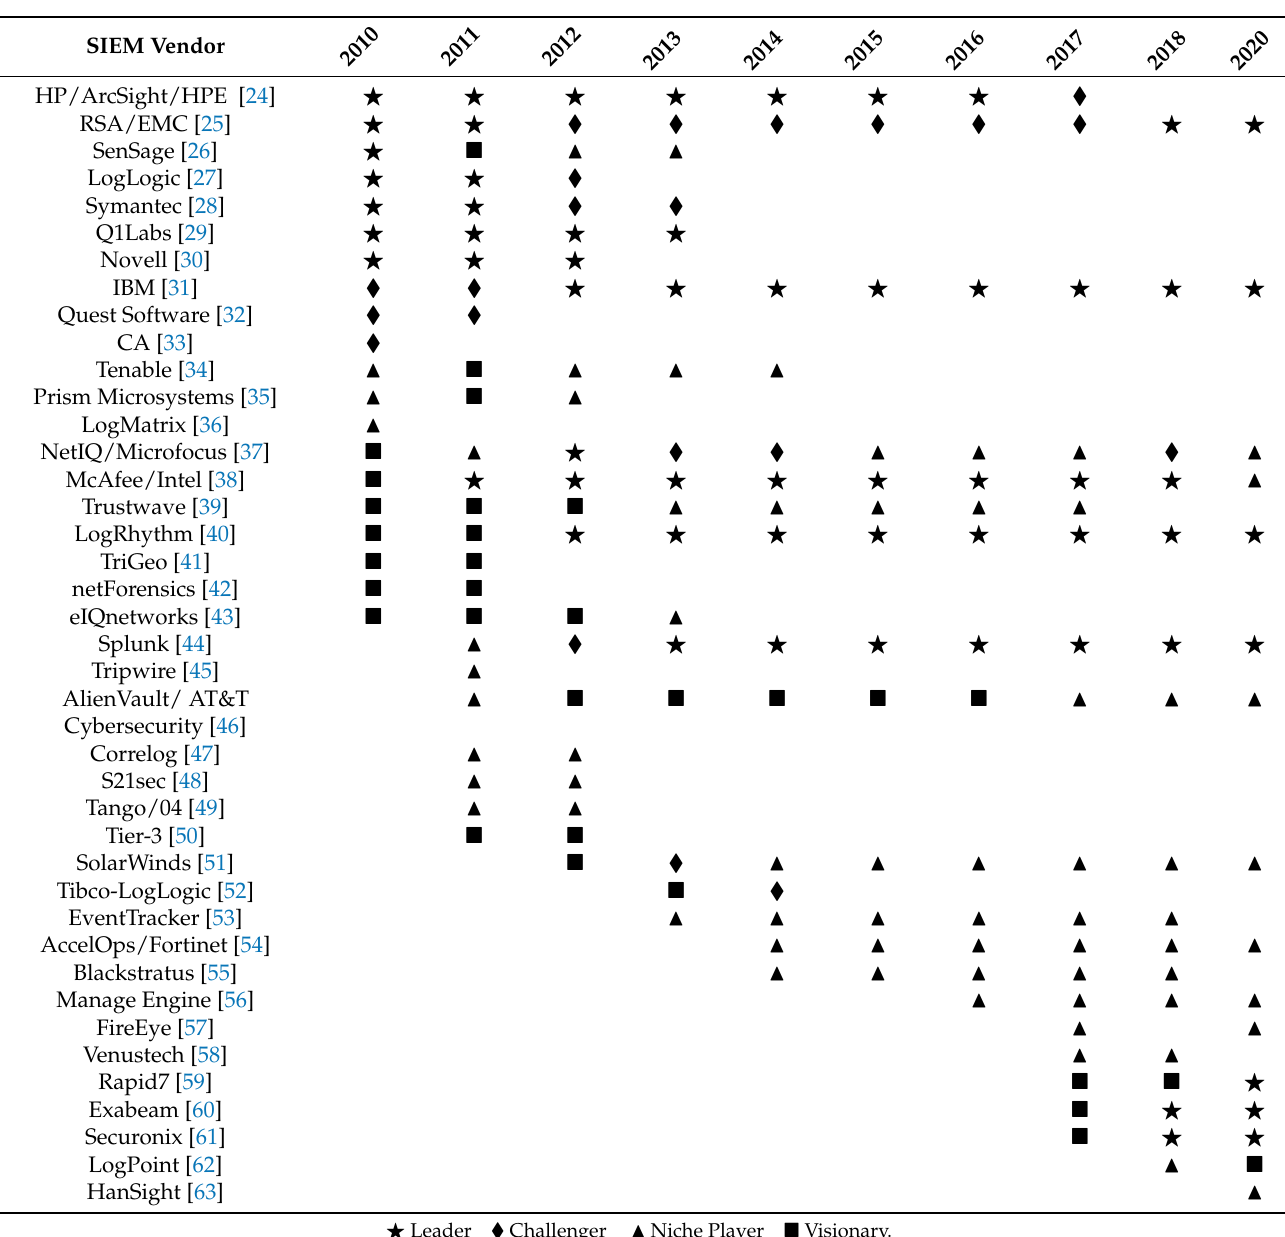
Table 1. SIEM vendors